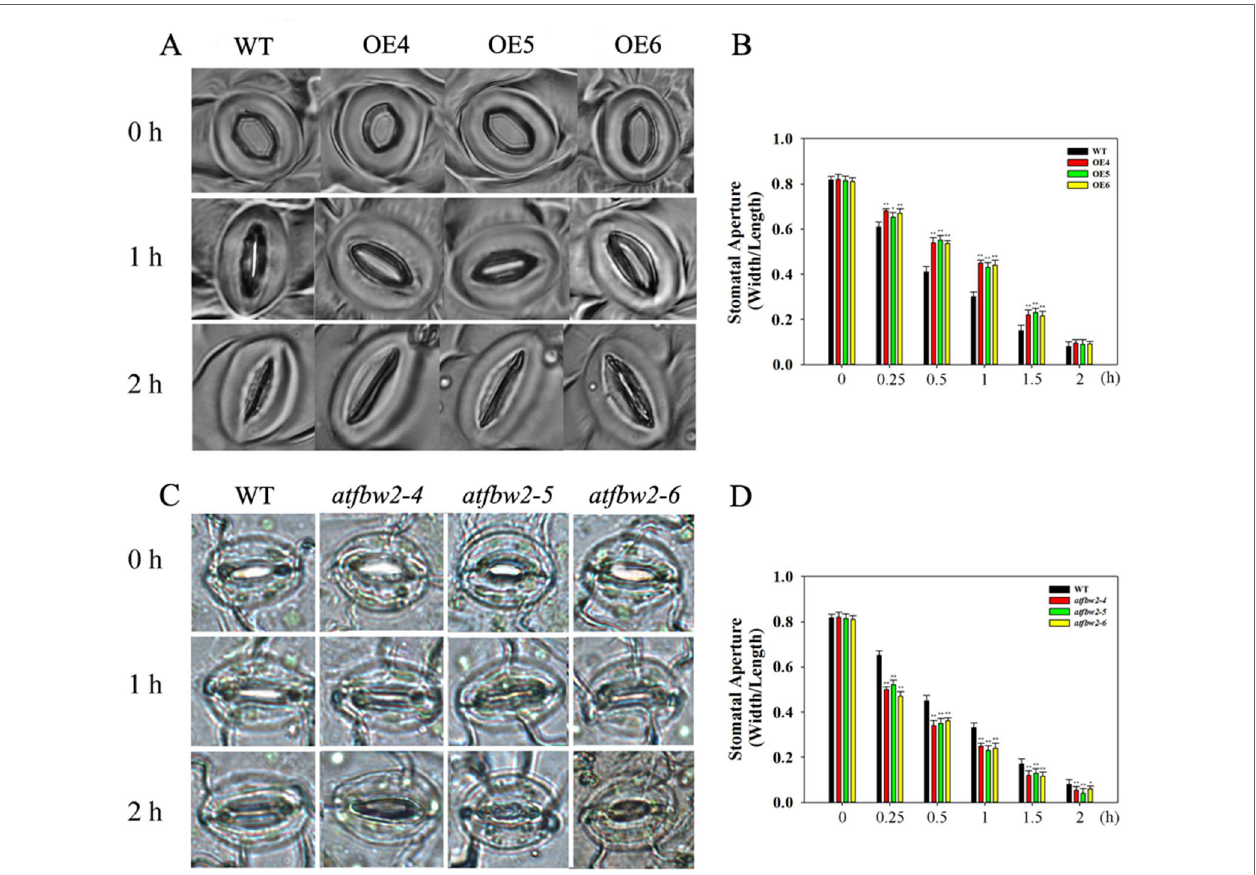
FIGURE 8 | Stomatal closure response to ABA treatment in Arabidopsis plants. Stomatal closure phenotype of WT, OEs (OE4, OE5, OE6) (A) , and WT, mutants ( atfbw2-4 , atfbw2-5, atfbw2-6 ) (C) . Stomatal aperture of WT and overexpression of TaFBA1 (B) , WT and mutants ( atfbw2-4 , atfbw2-5, atfbw2-6 ) (D) at different time points. Four-week-old Arabidopsis seedlings were treated with or without ABA for 2 h. Stomatal apertures (the ratio of width to length) were measured. Data represent the mean ± SE of three biological replicates. * P < 0.05; ** P <